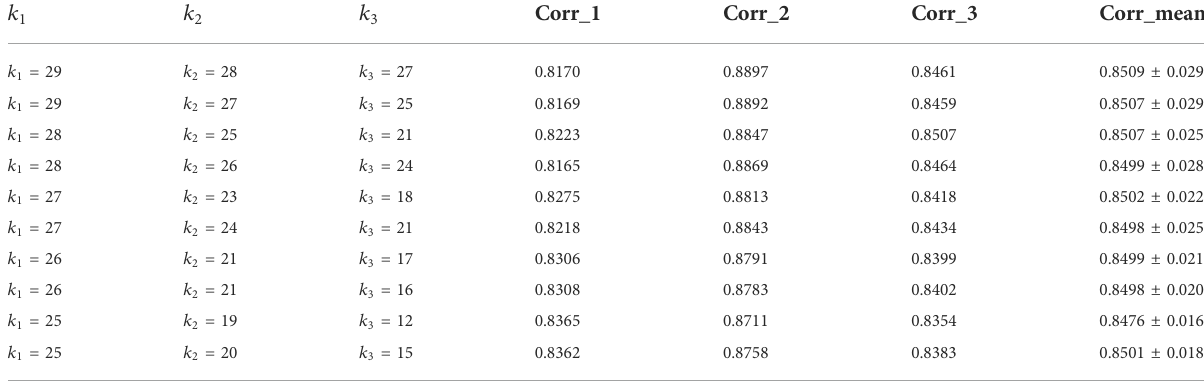
TABLE 1 Reconstruction performance of the algorithm under different k values in the neural network layer. k k 1